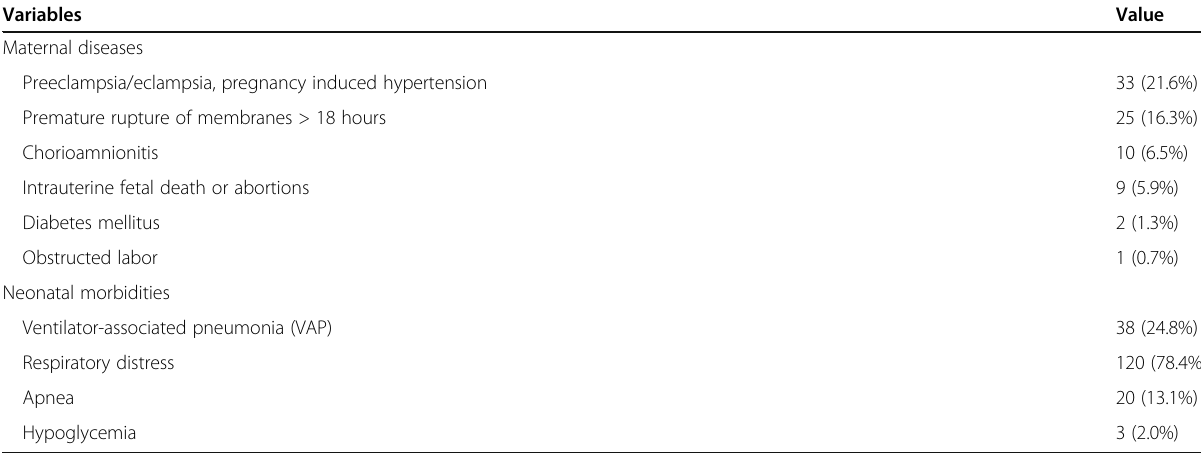
Table 2 Maternal and neonatal illnesses of the studied sample ( n = 153)